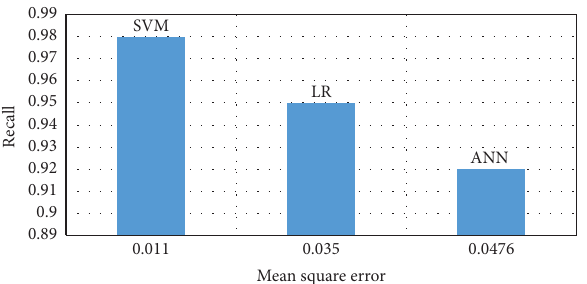
Figure 18: Depicting recall of test images of a new proposed hybrid learning approach by SVM, LR, and ANN machine classifers with mean square